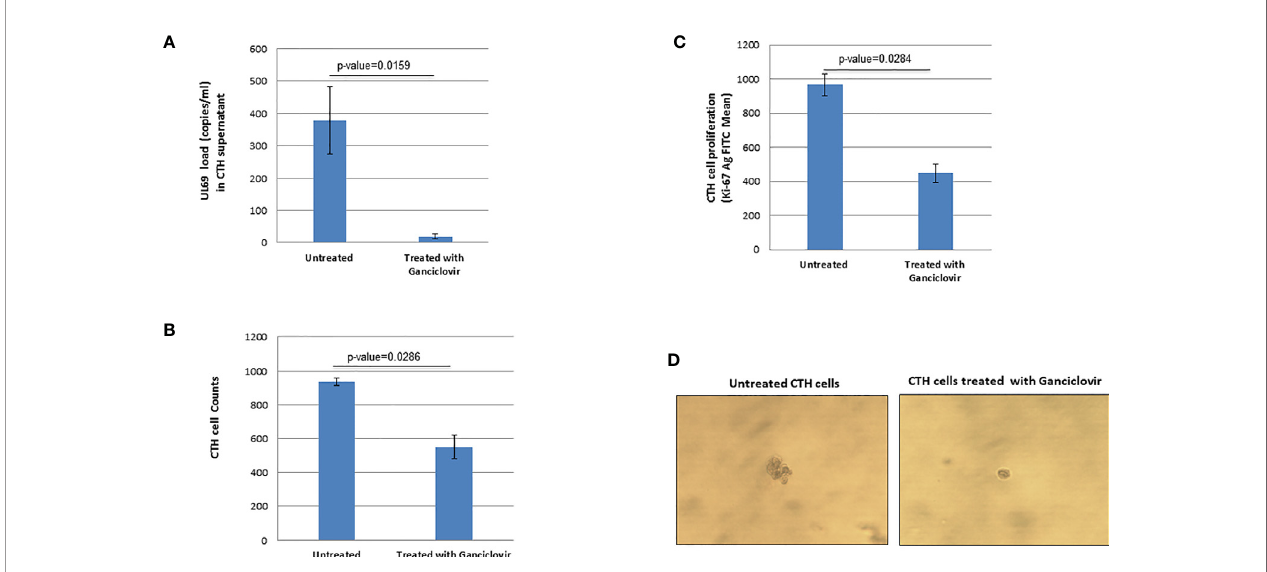
FIGURE 4 | Ganciclovir treatment of CTH cells decreases UL69 viral load, cell count, and cellular proliferation in culture and reduces colony formation in soft agar. (A) Untreated and ganciclovir-treated (20 µM for 4 days) CTH cells were compared for detection of UL69 gene by qPCR, (B) cell counting under the microscope (total magni fi cation of 200x), (C) cellular proliferation as measured by Ki67 antigen quanti fi cation by fl ow cytometry, and (D) colony formation in soft